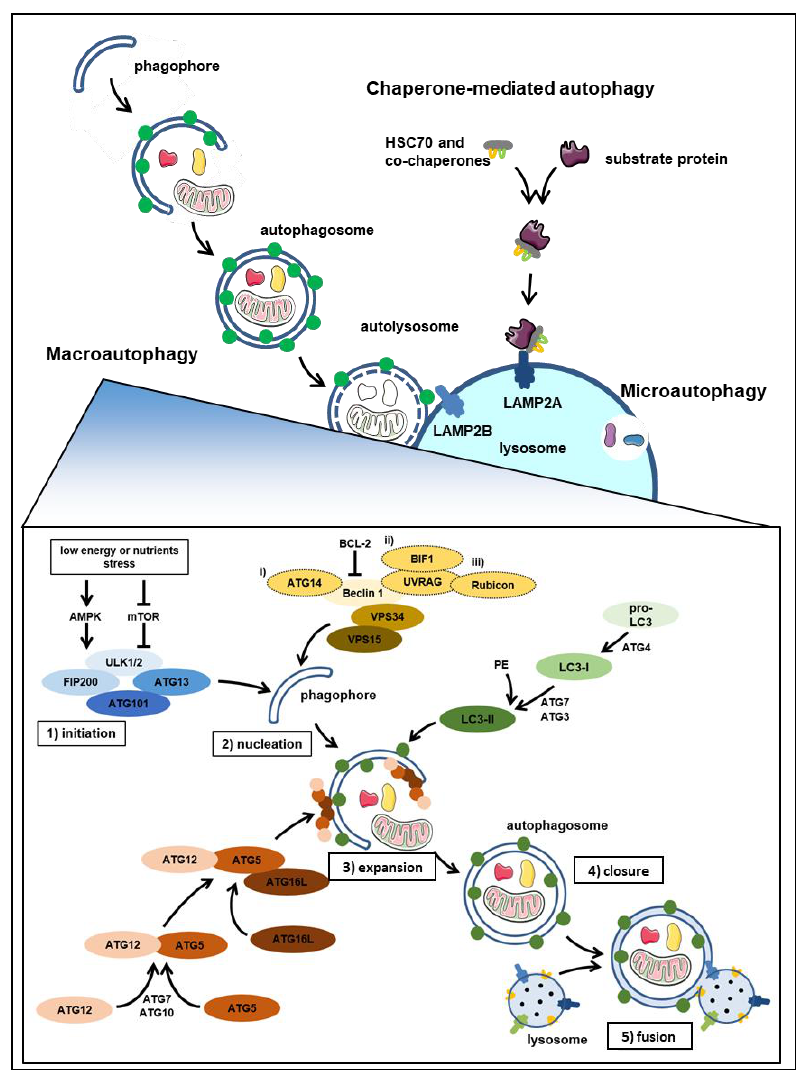
Figure 1. The autophagy machinery: Macroautophagy: After initiation, several autophagy proteins, including LC3B and the ATG12-ATG5-ATG16L1 complex are recruited to the pre-autophagosomal